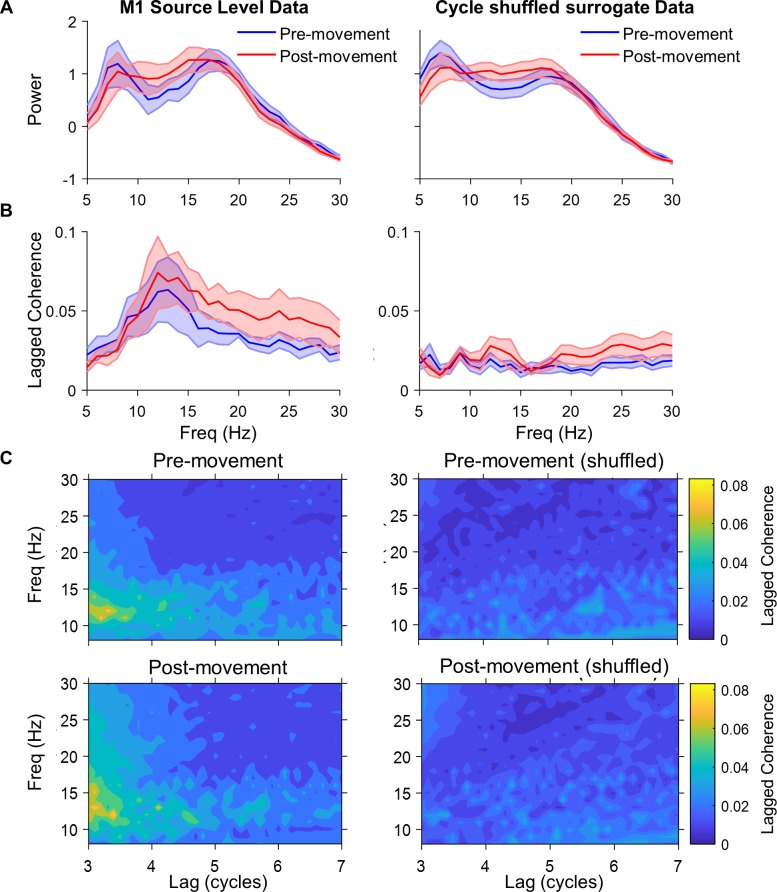
Motor cortical phase lagged coherence.(A) Mean PSD for all subjects (±SEM) for a virtual electrode from M1 (hand knob), response-locked data, with 1/f noise component removed (5–30 Hz). The power profile is preserved in the surrogate, cycle-shuffled data (right panel). Data shown both pre- and post- movement. (B) Lagged coherence (3 cycles) for real data (left) and cycle-shuffled surrogate control data (right). Note the absence of a strong peak in lagged coherence at the beta power peak of 18 Hz. (C) Lagged coherence for beta activity (13–30 Hz) rapidly falls off further after 3 cycles, compatible with burst activity (here shown for both pre-movement [top] and post-movement [bottom]). The underlying data can be found at https://osf.io/eu6nx/. PSD, power spectral density.